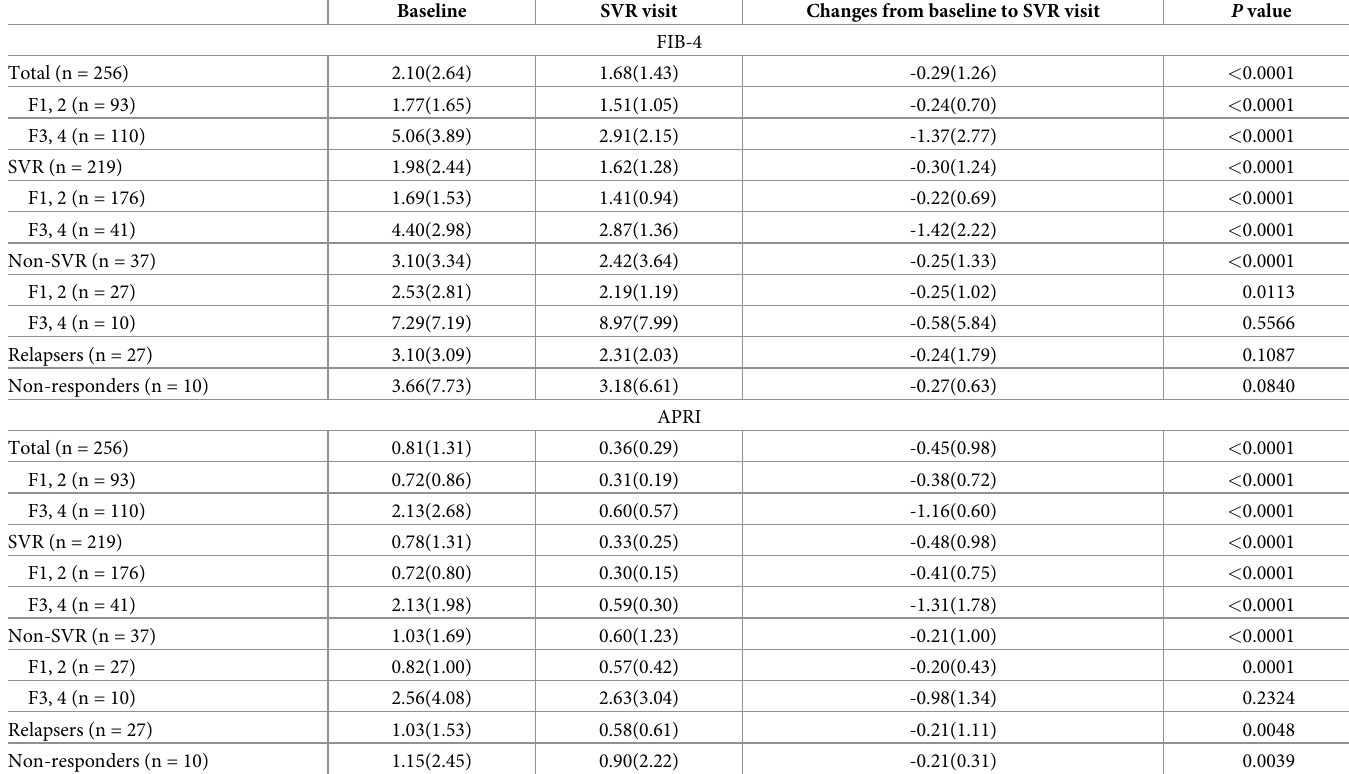
Table 3. Stratified changes in FIB-4 index and aspartate aminotransferase-to-platelet ratio index from baseline to sustained virologic response visit.